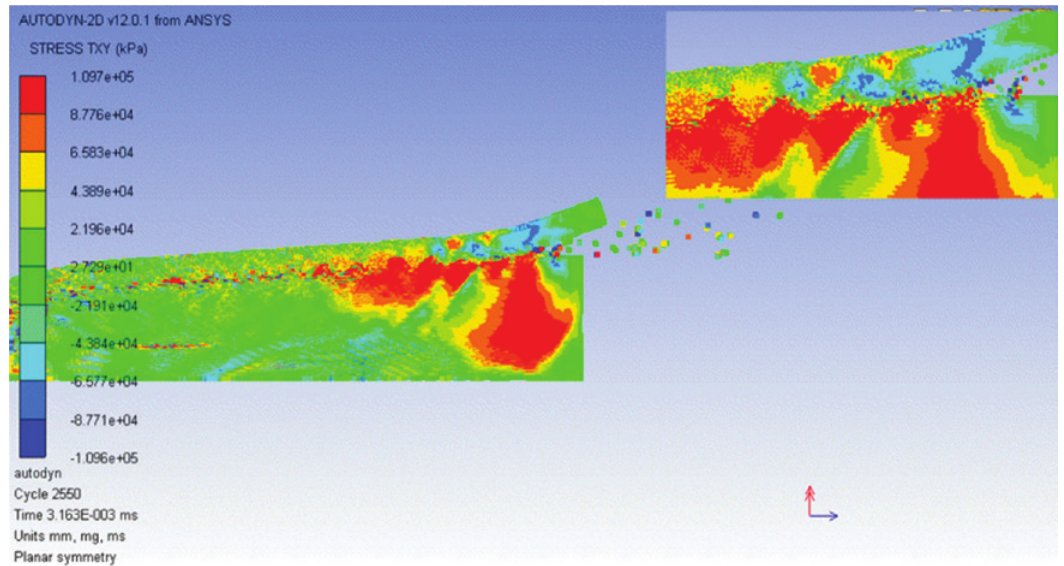
Figure 8: The shear stress distribution of combination in the